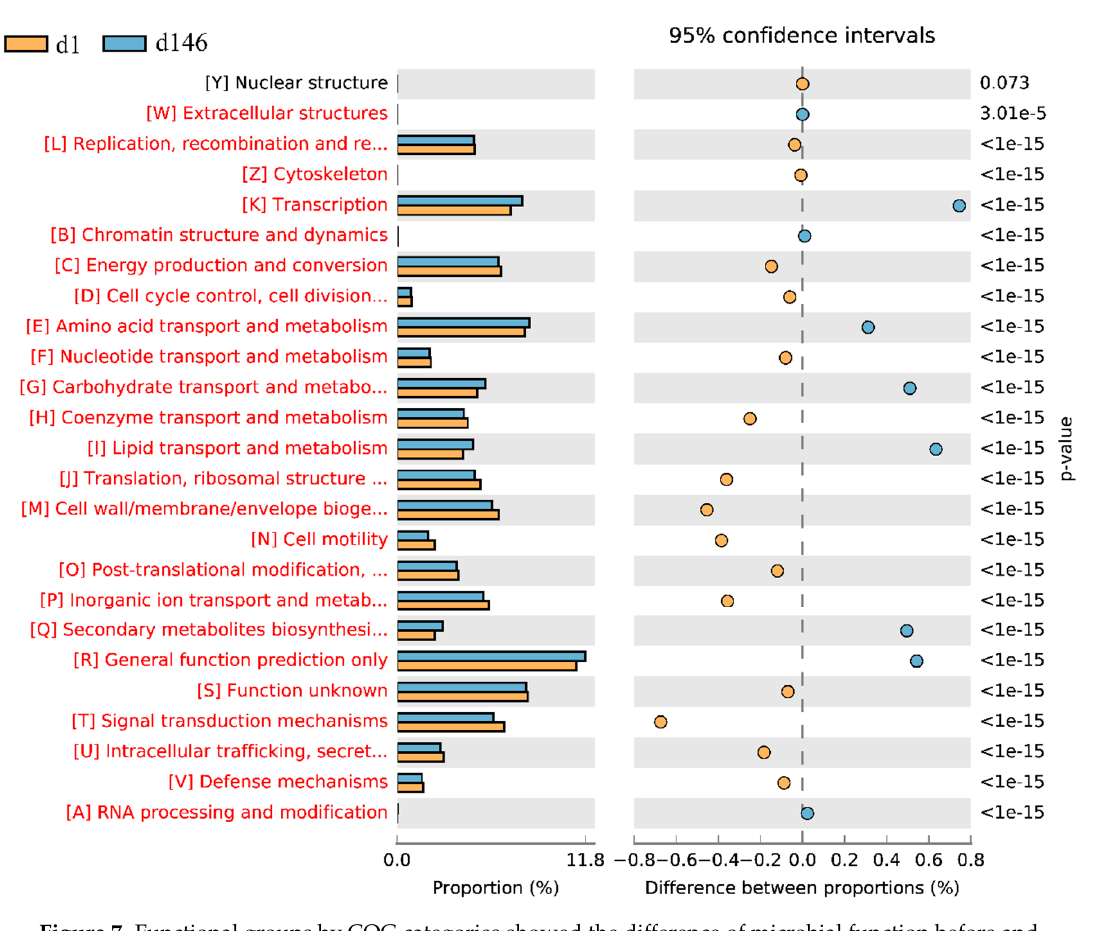
Figure 7. Functional groups by COG categories showed the difference of microbial function before and after MBT treatment in the river (The left was the abundance of different functional groups; the middle was the percentage of functional group abundance with 95% confidence intervals; the p value was shown in the rightmost; p < 0.05, means significant difference).